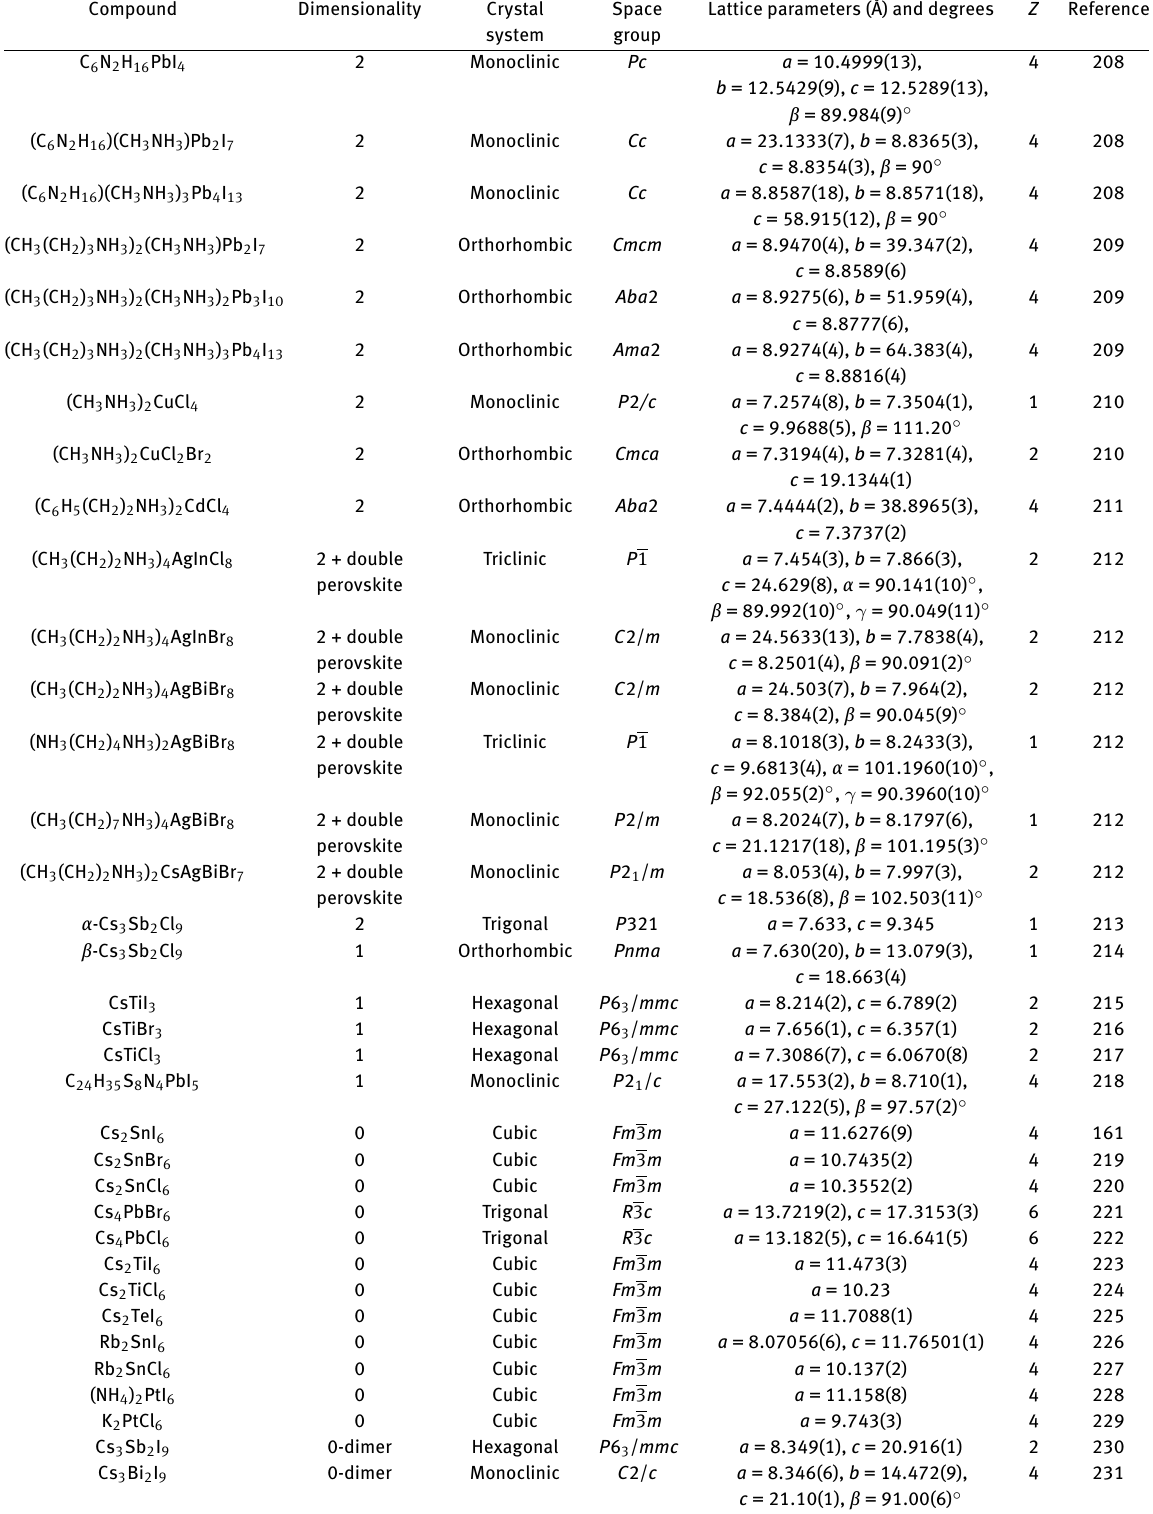
Table 13: Crystal systems of low-dimensional perovskite crystals. Compound Dimensionality Crystal